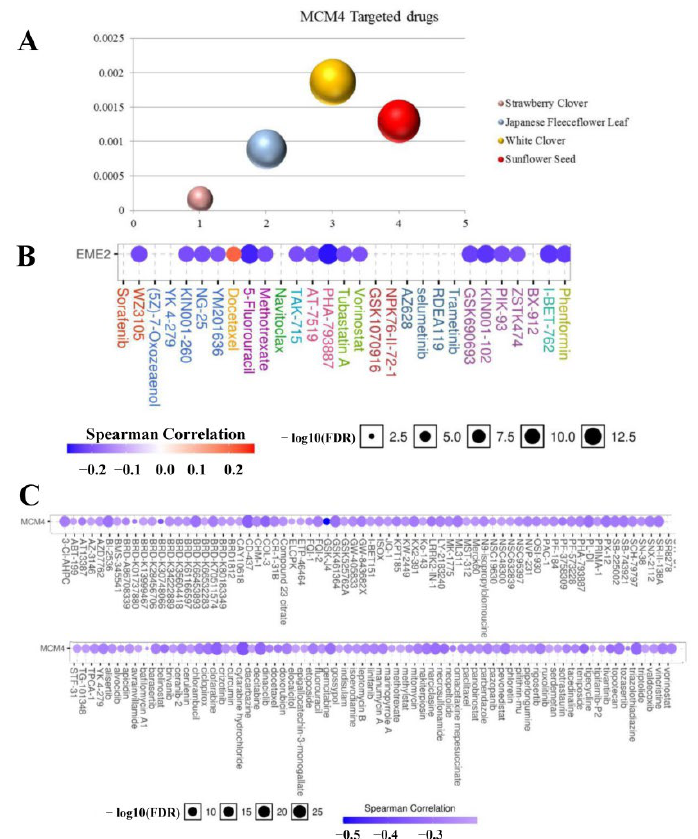
Figure 8. Possible targeted drugs of MCM4. ( A ) Acquiring the targeted drug of MCM4 through HERB database. ( B ) Evaluate the correlation between drug sensitivity and MCM4 by CTRP. ( C ) Evaluate the correlation between drug sensitivity and MCM4 by